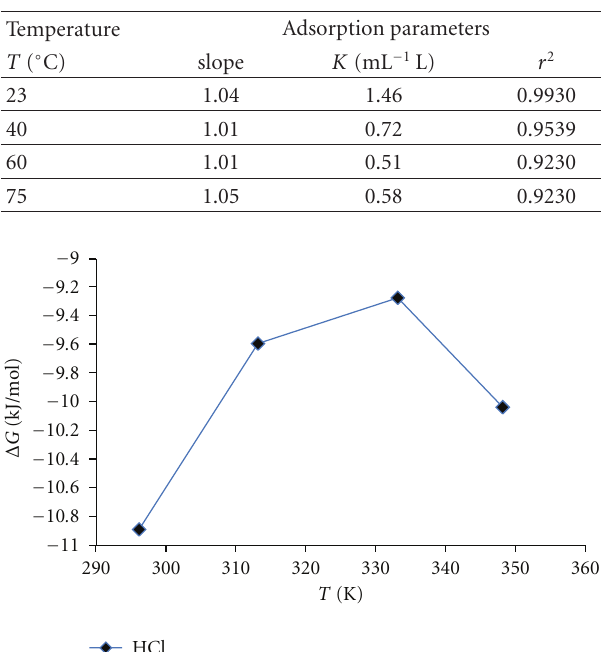
Table 5: Adsorption parameters for EEPD in 1MHCl obtained from Langmuir adsorption isotherms at di ff erent temperatures.